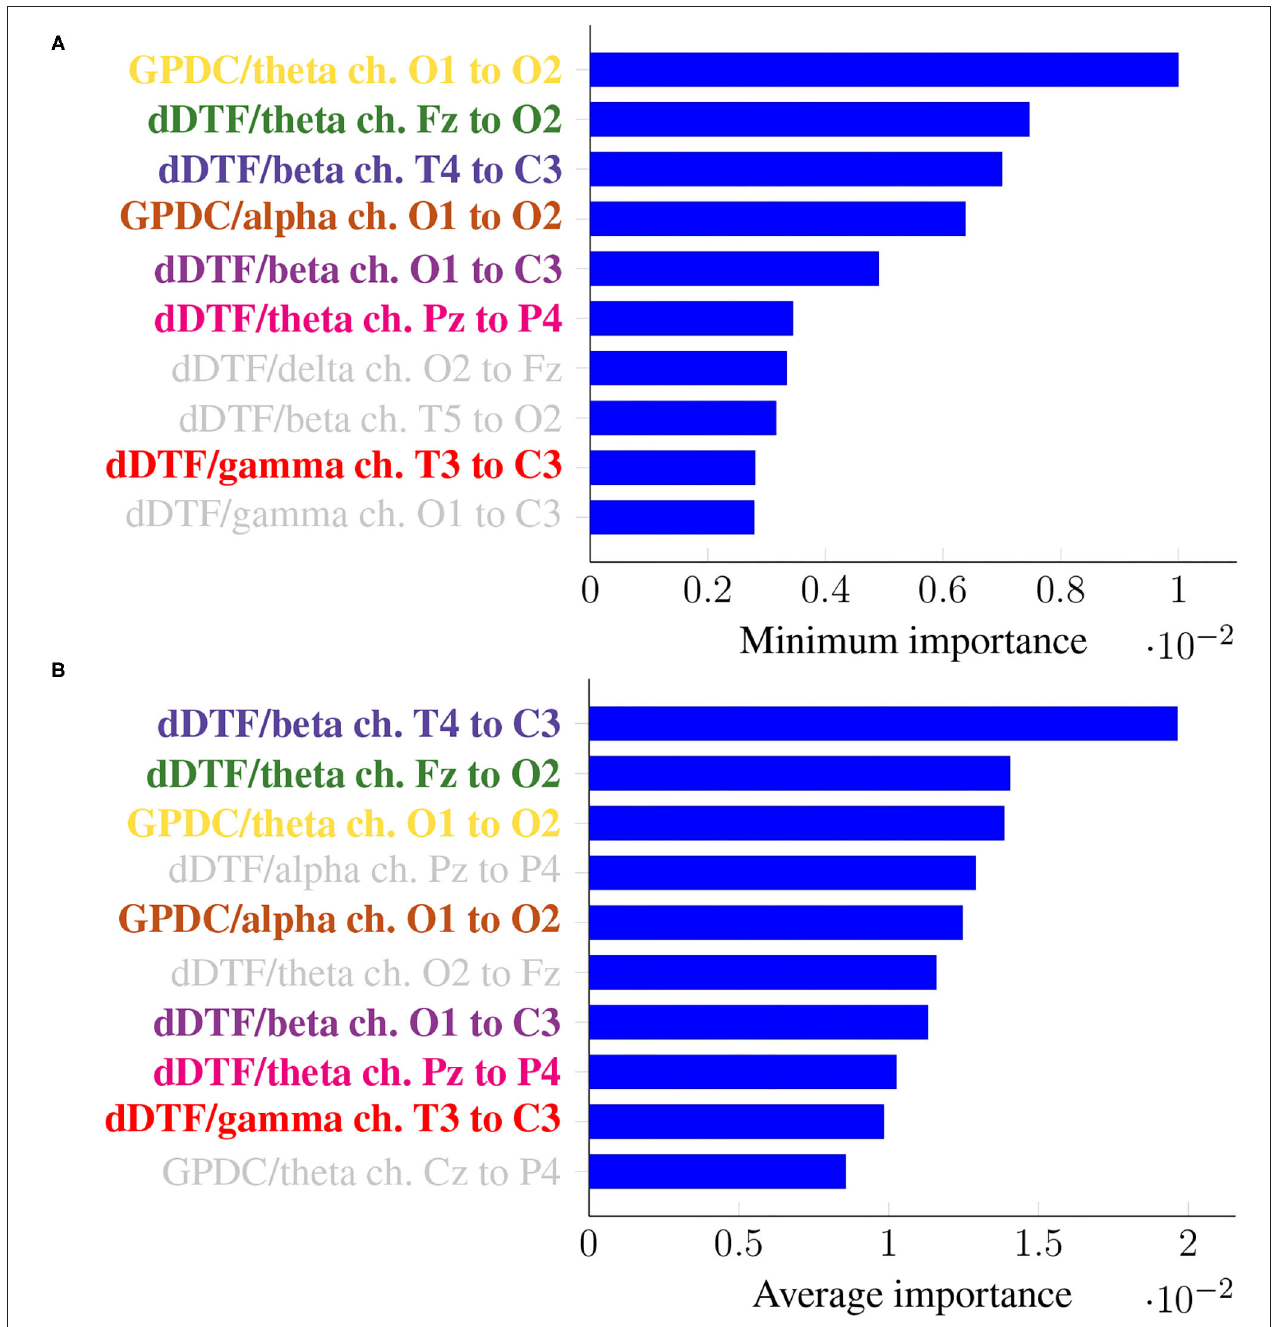
FIGURE 7 | Feature importance summarized across folds using the minimum (A) and the mean (B) for Leave-p-Subjects-Out cross-validation. Every feature is determined by the metric (left of “/”), the frequency band (right of “/”), and the EEG channels involved (notice the order is